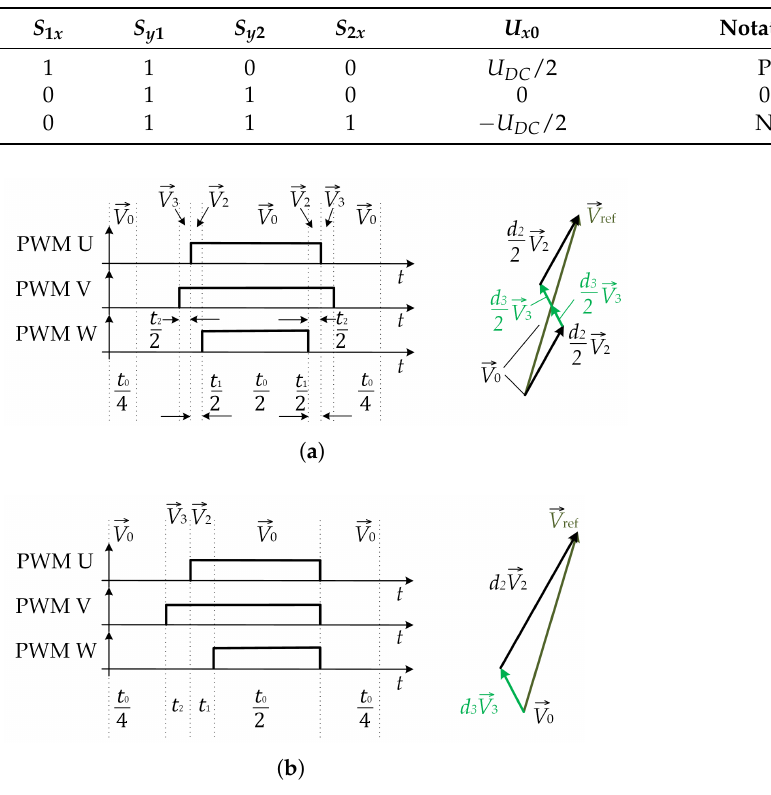
Figure 3. SVM pattern for Region 2: ( a ) using ordinary SVM; ( b ) using vector shifting to the rising edge.